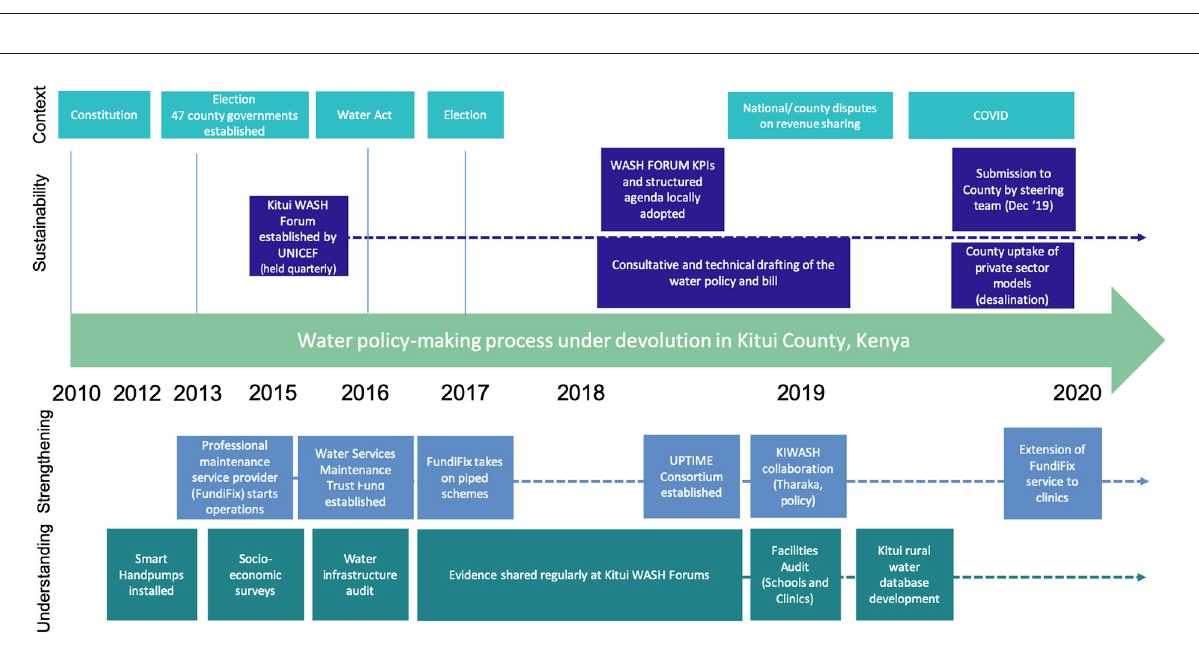
FIGURE2 Timeline of policy experimentation and water policy-making in Kitui County,